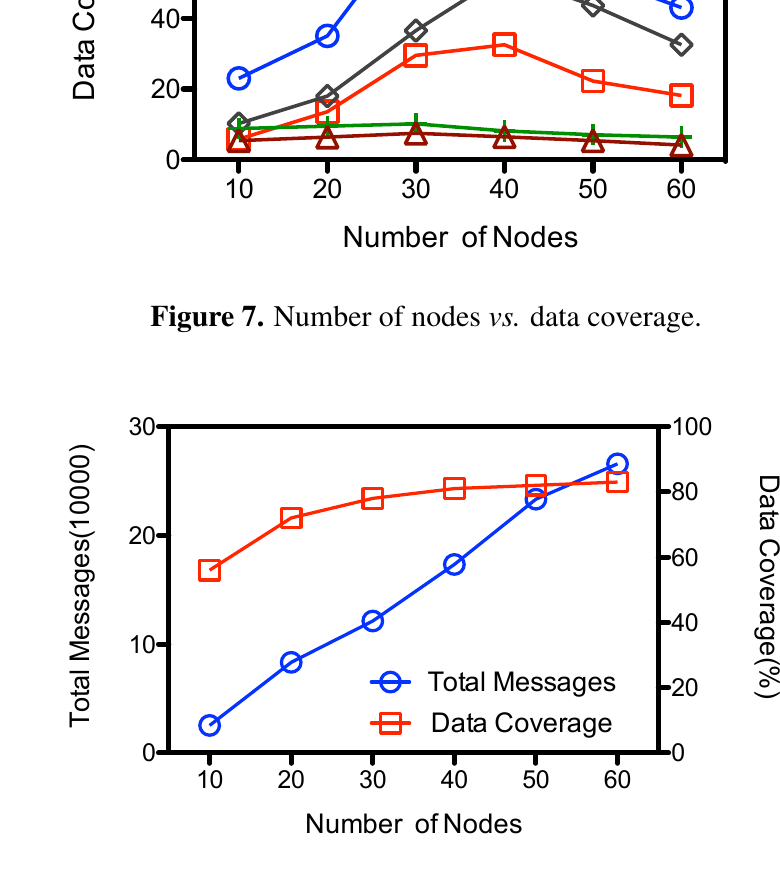
Figure 8. Performance of ADG with 2 MC